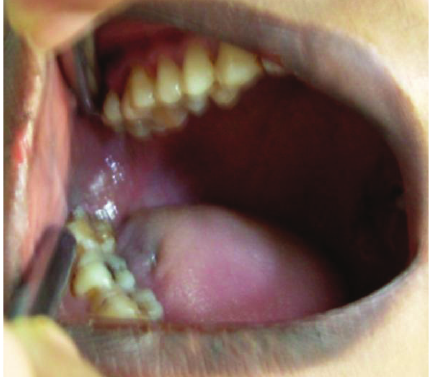
Figure 7: Intraoral view showing the broken needle.